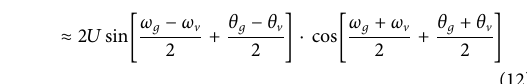
Frontiers in Energy Research |